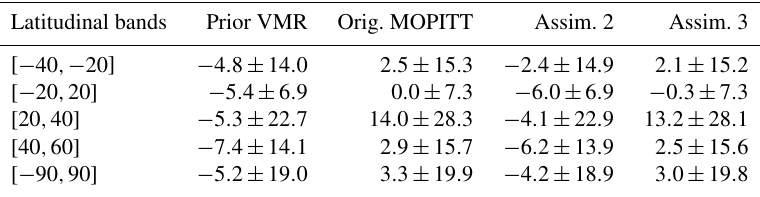
Table 4. Comparisons of GEOS-Chem-simulated mole fractions assimilating MOPITT data with HIPPO-2 observations. Uncertainties are 1 σ . Units are in parts per billion. See text for descriptions of the assimilations.